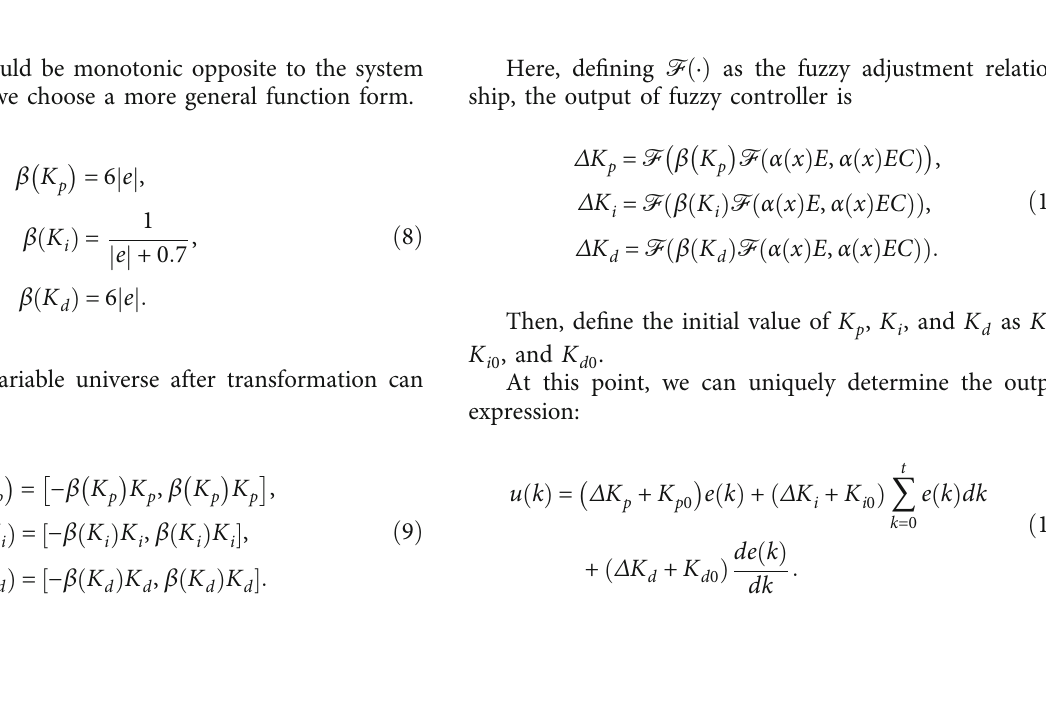
Figure 4: VUFPID controller structure diagram; e , ec are the error and its rate of change, respectively, the contraction-expansion factors of inputs and outputs are de fi ned as α ð e Þ , α ð ec Þ , β ð K p Þ , β ð K i Þ , and β ð K d Þ